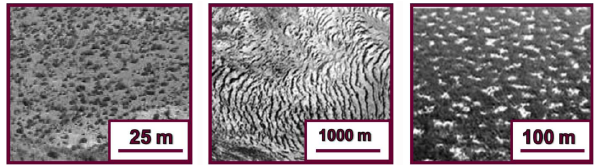
Fig. 1. Vegetation patterns typical shapes and dimensions (edited from D’Odorico et al.,